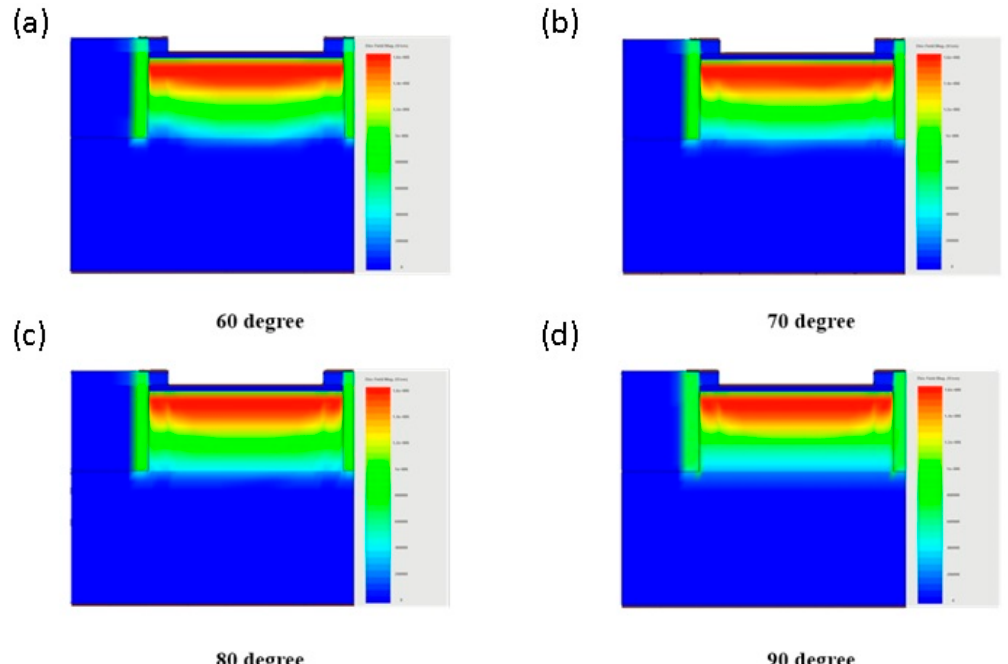
Figure 9. Simulated electric field distributions for GaN p - i - n diodes with different bevel angles: ( a ) 60°, ( b ) 70°, ( c ) 80°, and ( d ) 90°. The simulated reverse bias was 500 V.